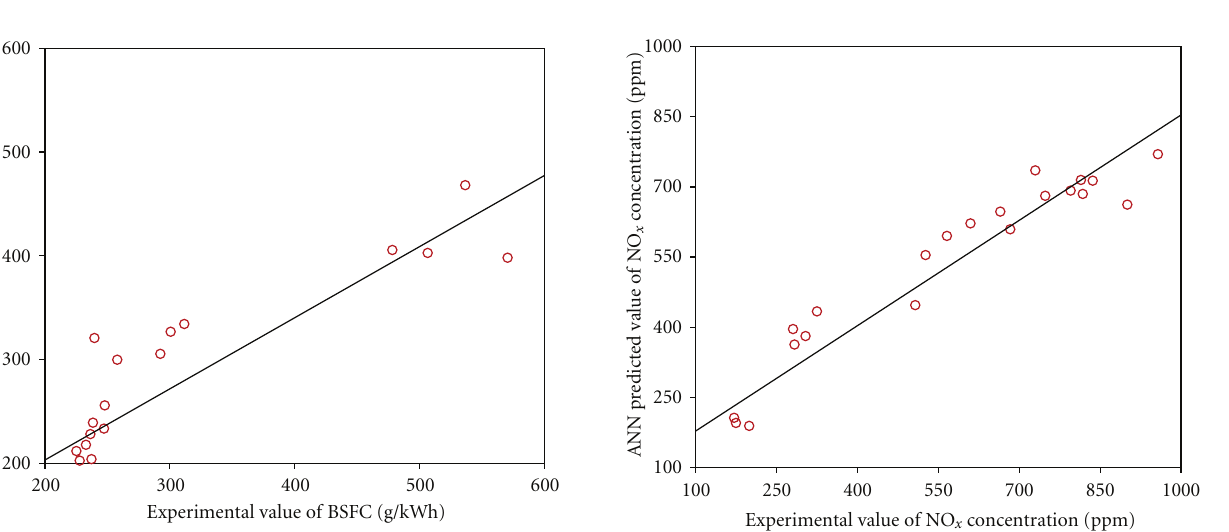
Figure 8: Comparison between ANN predicted values and the corresponding actual values for BSFC.